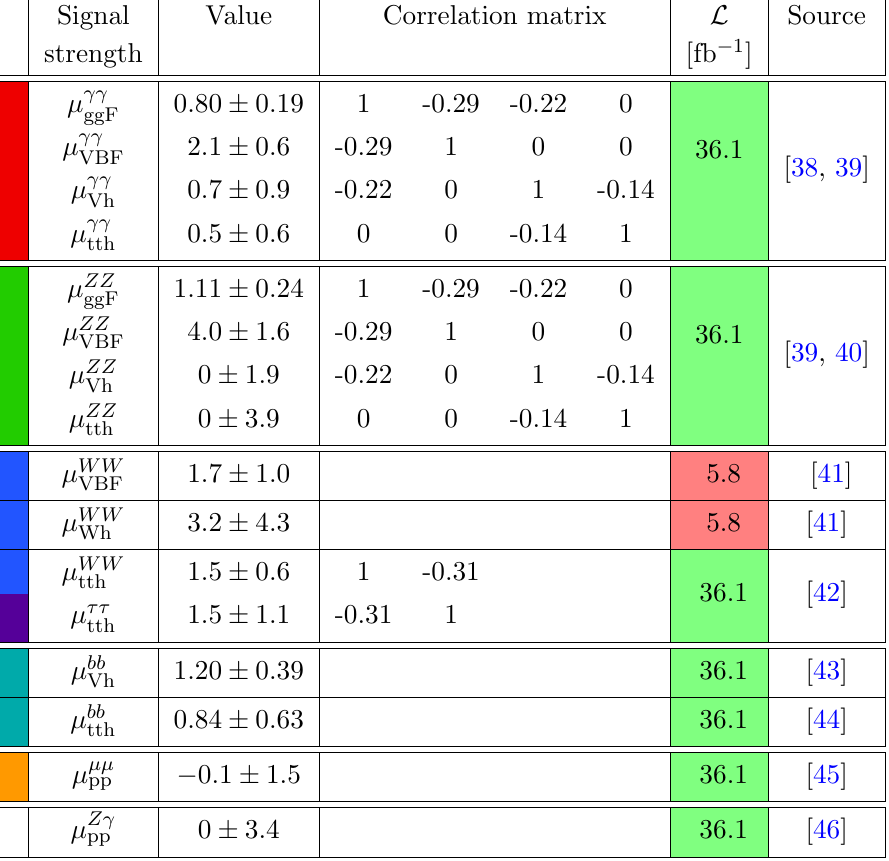
Table 3 . Run 2 h signal strengths measured by ATLAS. Again, correlations below 0.1 were treated to be 0. The colours in the (cid:12)rst column correspond to the ones in (cid:12)gures 1 and 2. In the (cid:12)fth column, we highlight the underlying integrated luminosity with red, yellow and green, depending on whether the measurement is based on few, moderate or the full Run 2